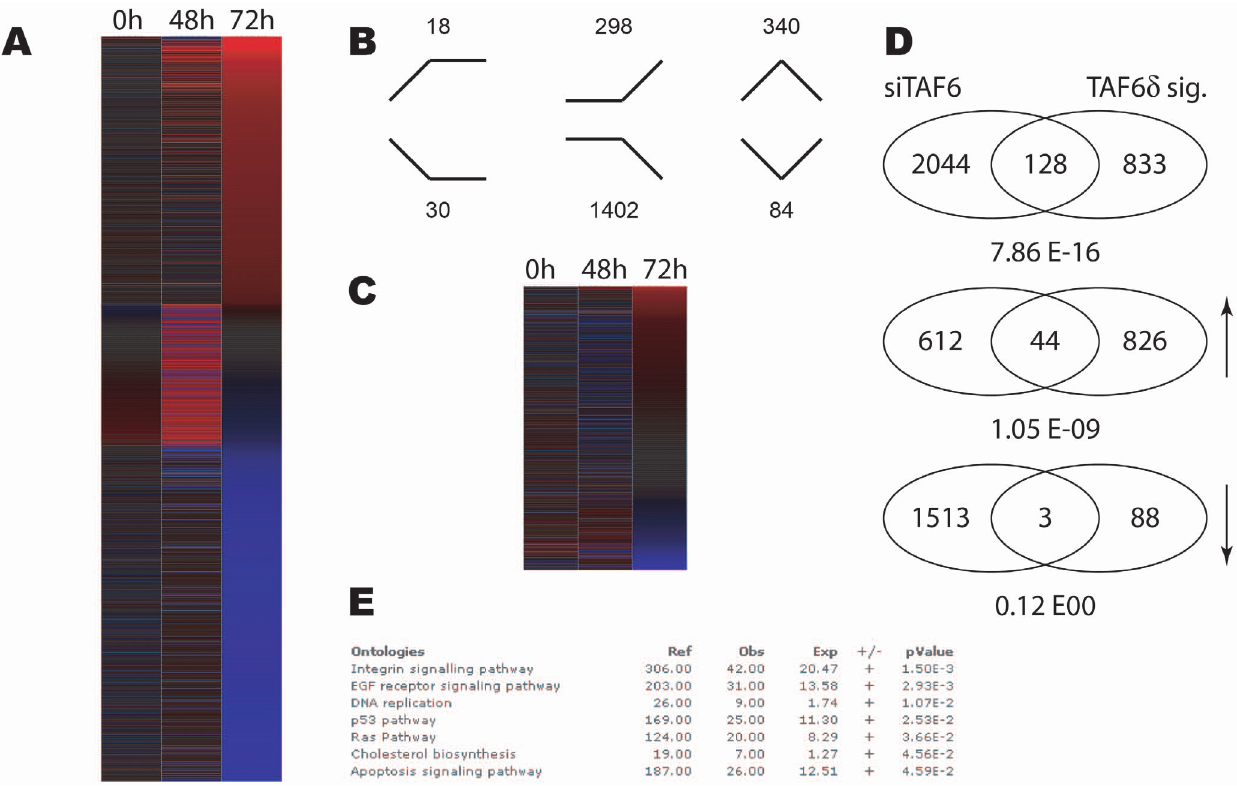
Figure 2. Distinct impact of TAF6 d induction versus total TAF6 mRNA depletion on the transcriptome of HeLa cells. (A) Heat map showing the impact of statistically significantly (p , 0.05) changes in gene expression during TAF6 mRNA depletion by siRNA at 48 and 72 hours post transfection. Red indicates induction and blue repression. Genes were ordered according to fold change at 72 hours post transfection. (B) Distribution of expression profiles amongst the six possible outcomes. Genes upregulated or downregulated at the both time points are schematized with lines. (C) The previously defined TAF6 d transcriptome signature compared to the transcriptome resulting from depletion of total TAF6 mRNA. The heat map shows the gene expression during siRNA-mediated total TAF6 mRNA depletion for the 961 TAF6 d signature genes. (D) Venn diagrams depicting genes subsets statistically significantly regulated by total TAF6 mRNA depletion versus by TAF6 d induction. Upper diagram contains all regulated genes, middle diagram includes induces genes (upward arrow) and the lower Venn diagram includes repressed genes (downward arrow). (E) Gene ontology analysis of statistically significantly regulated genes during total TAF6 mRNA depletion. Enriched pathways are shown with their associated